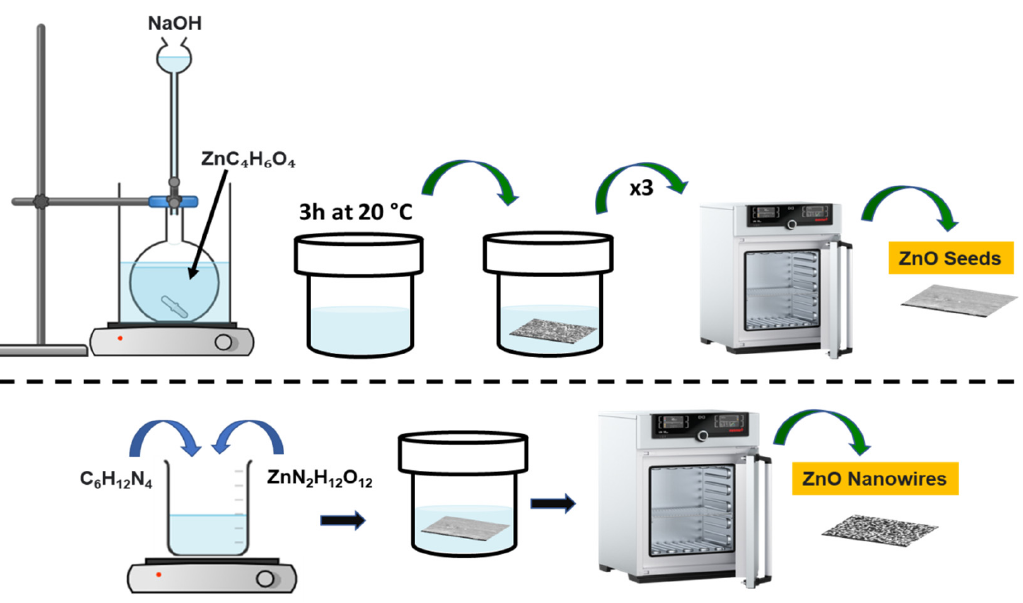
Figure 1. Schematic illustration of the hydrothermal growth of ZnO nanorods on seeded stainless steel.